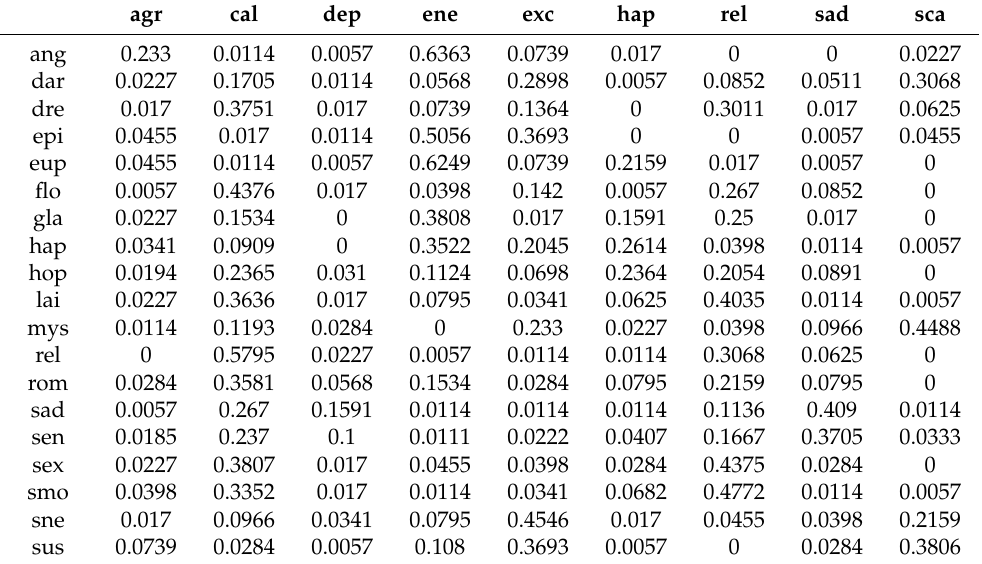
Table 4. Mapping emotions from the Epidemic Sound database to the proposed mood model.